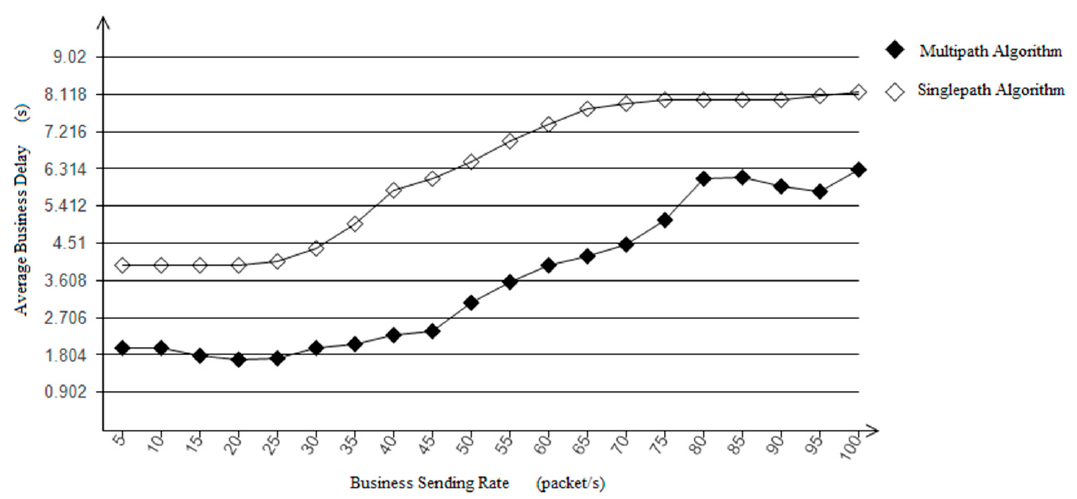
Figure 8. Average business wait delay comparison chart.